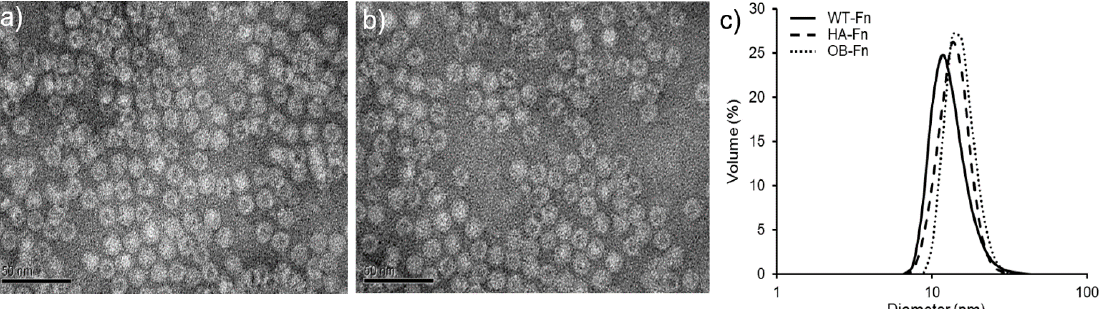
Figure 1. Characterization of bone-targeting ferritin nanoparticles. TEM images of ( a ) OB-Fn and ( b ) HA-Fn, ( c ) Size distribution of OB-Fn, HA-Fn, and WT-Fn measured by DLS. Scale bar 50 nm.